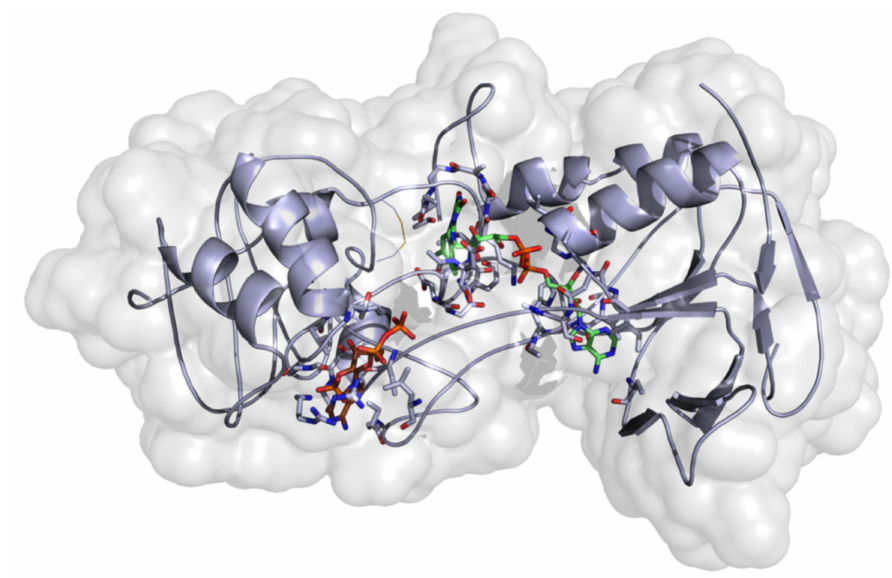
Figure 3. Homology model of thioredoxin reductase of O. ochengi.